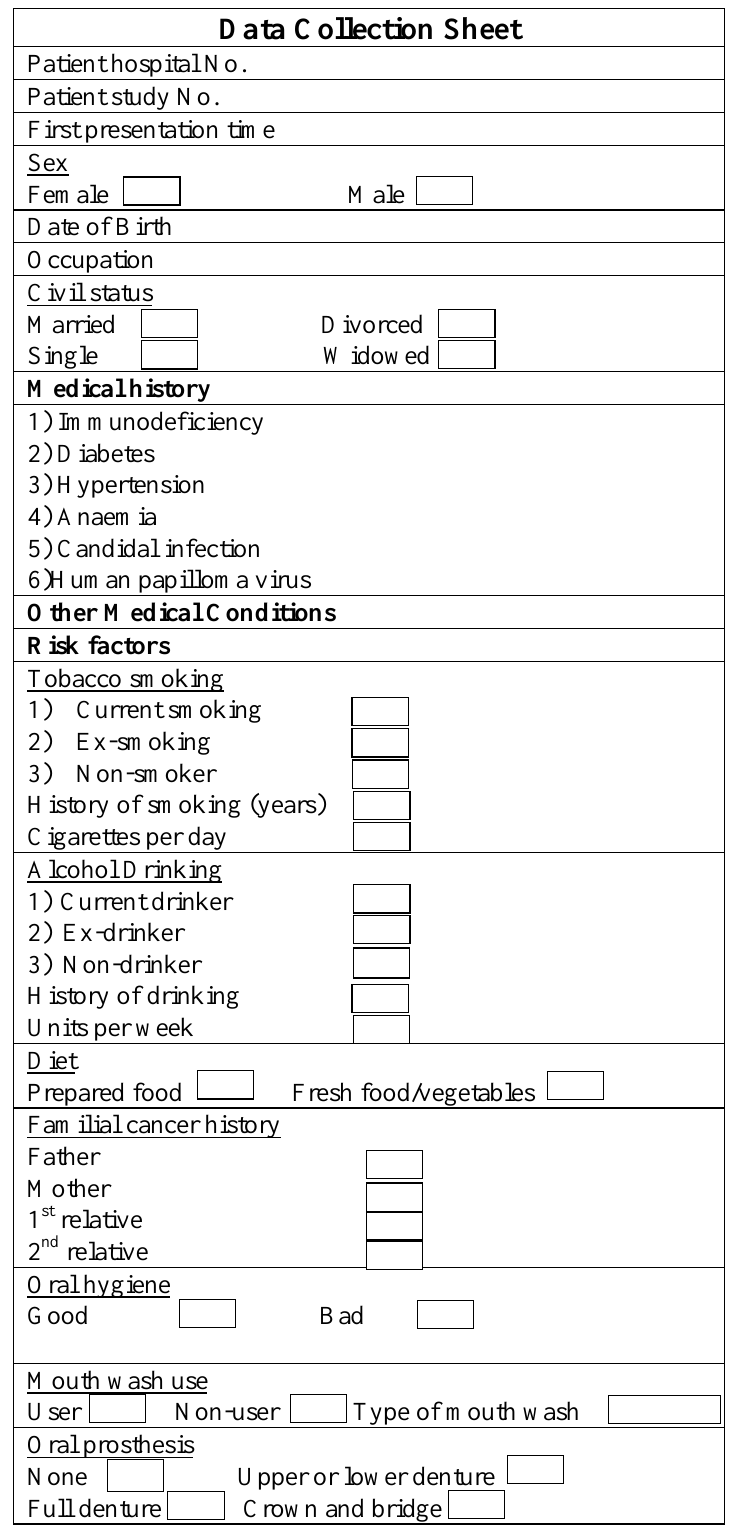
Figure 1: Recommended risk factor assessment case